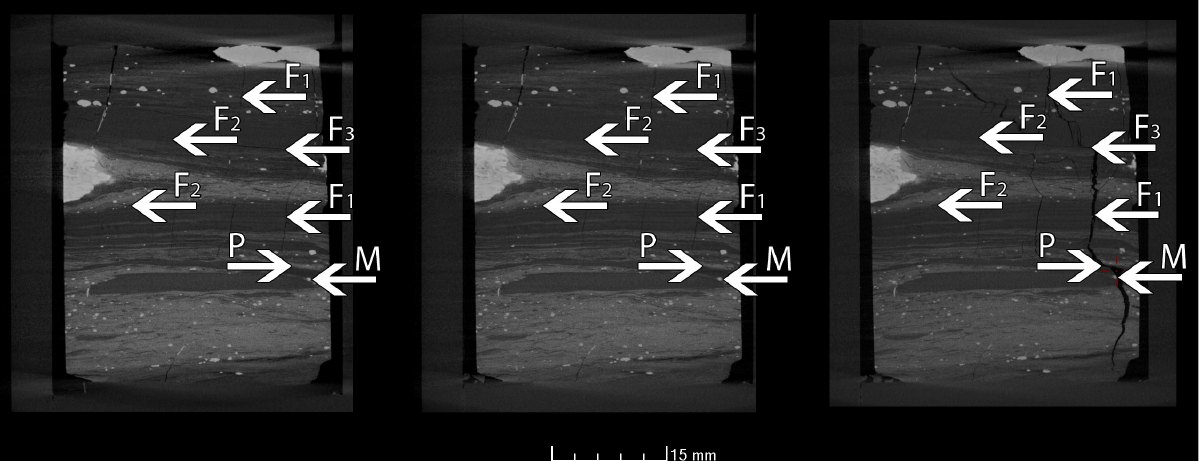
Figure 3: Comparison of the before (left) and after (right) tomogram of a particle compressed parallel to the bedding plane in the Monsanto tensometer.